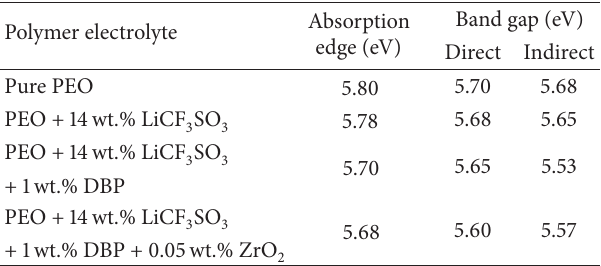
Table 2: Absorption edge and band gaps values for SPE. Band gap (eV) Absorption Polymer electrolyte edge (eV) Direct Indirect Pure PEO 5.80 PEO + 14wt.% LiCF SO 3